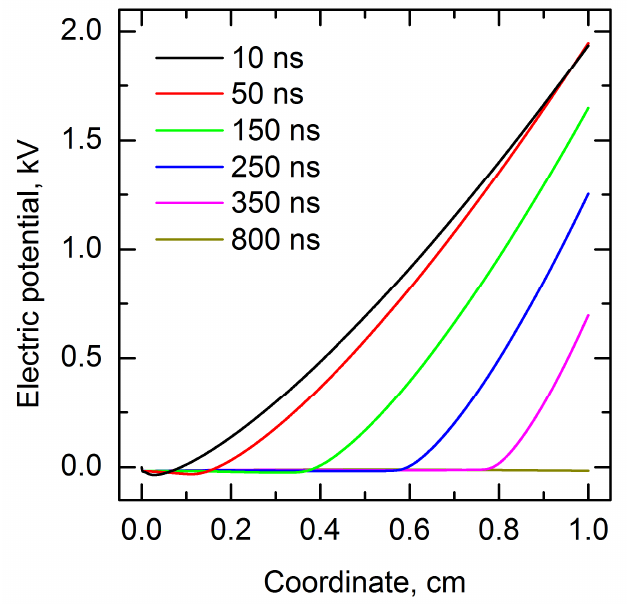
Figure 7. Spatial distribution of the electrostatic potential in vacuum diode with zinc cathode given for selected time